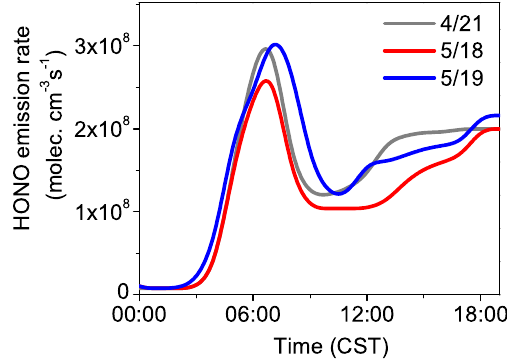
Fig. 2. HONO emission rate in the altitude interval between 0.1–1m